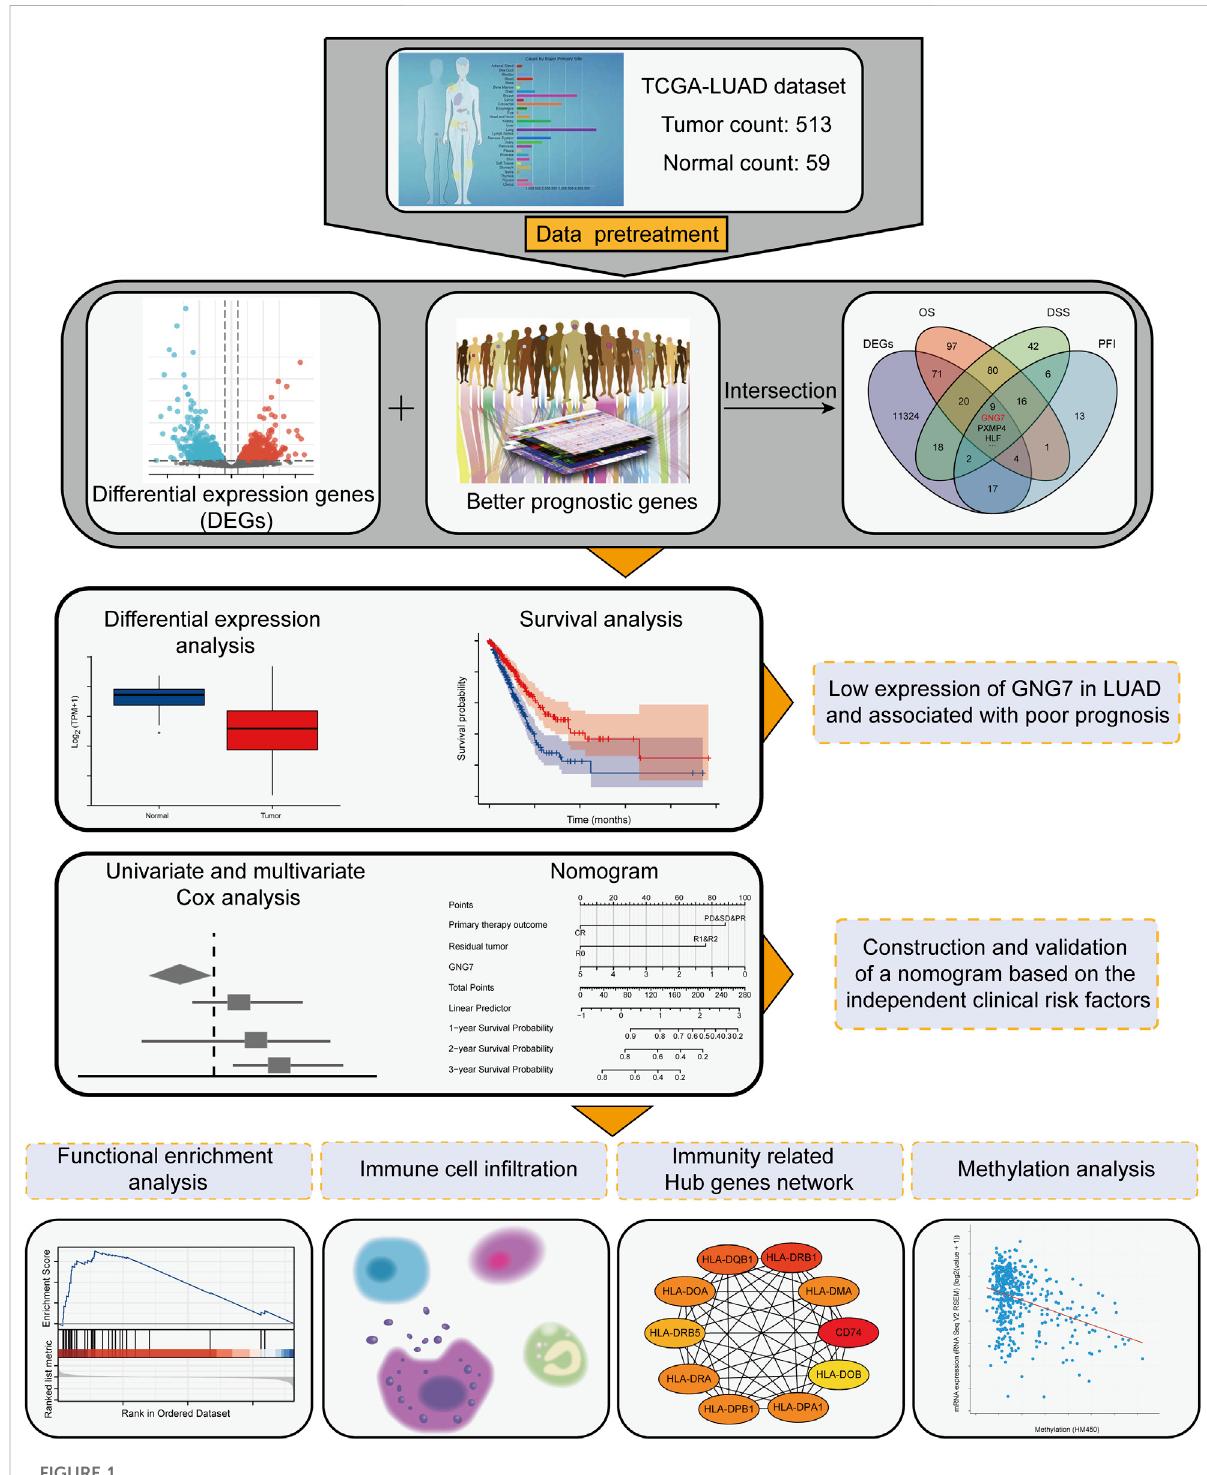
FIGURE 1 Work fl ow for screening of key genes and downstream